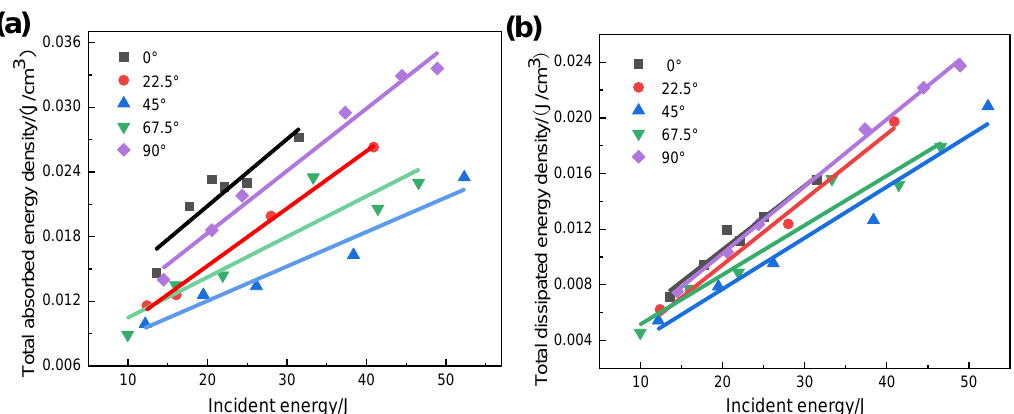
Figure 8. The relationship curve of total absorbed energy density and total dissipated energy density with incident energy: ( a ) Total absorbed energy density; ( b ) Total dissipated energy density.